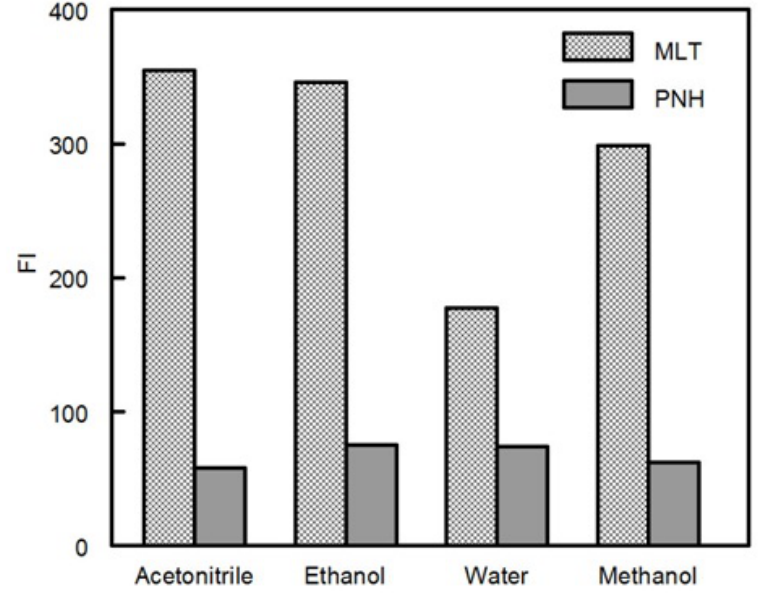
Figure 5. Effect of diluting solvent on FI of MLT and PNH (100 ng mL − 1